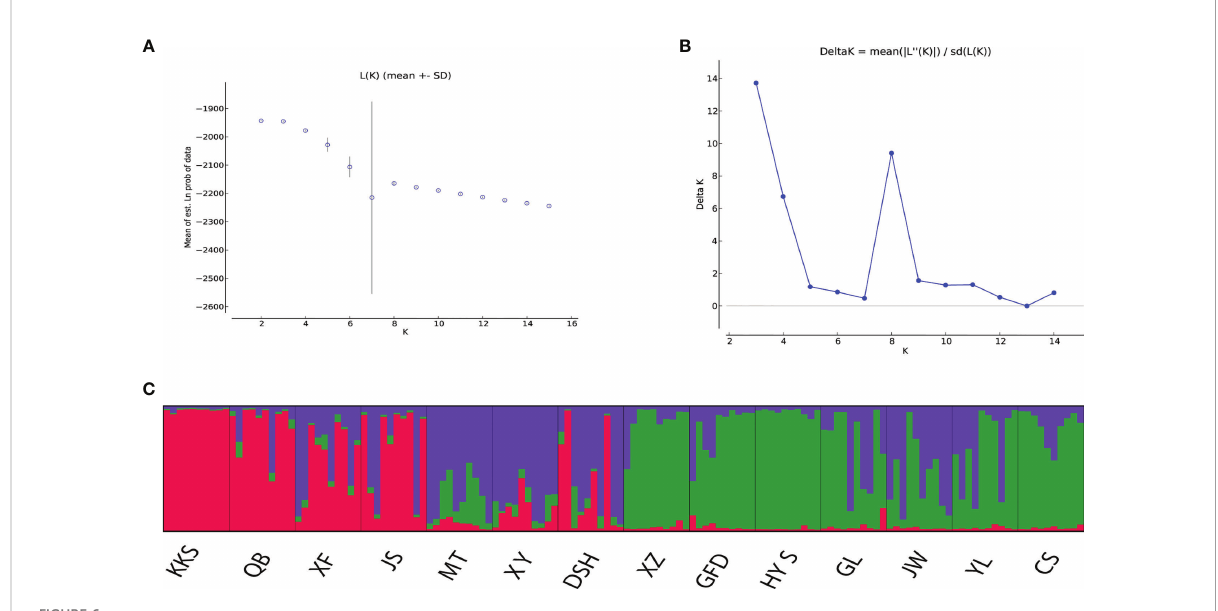
FIGURE 6 Results of STRUCTURE cluster of 140 individuals of Ch. utilis . (A) Mean log-likelihood (Ln(K)±S.D.). (B) Values of logarithm likelihood based on analysis by structure program. (C) Each of color bars represents a kind of genotypic